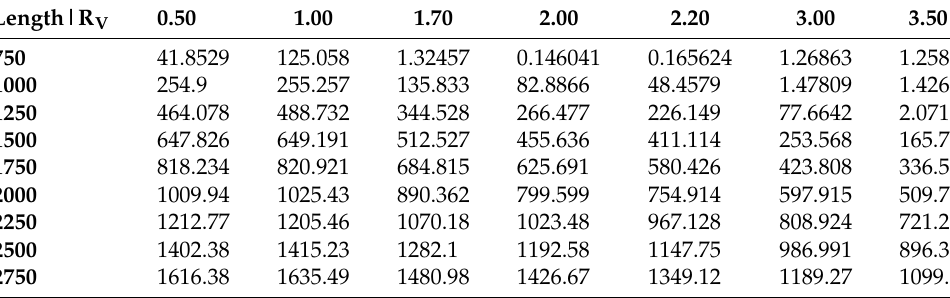
Table A5. Execution times in milliseconds for the GPU-based implementation of the decreasing ring simulation. On the left the number of cells (length) while on top the value considered for R V .